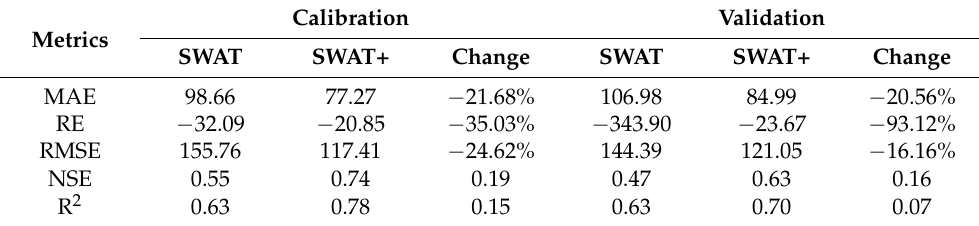
Table 2. Snowmelt runoff simulation accuracy of SWAT model and SWAT+ model.